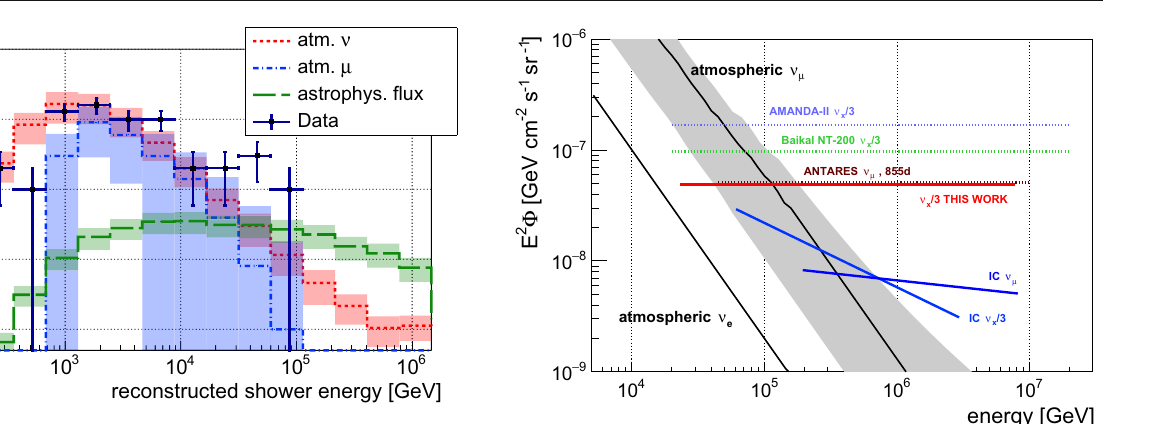
Fig. 5 The 90% C.L. upper limit on the diffuse all-flavour astrophys- ical neutrino flux obtained in this work ( solid red line ) in comparison to previously set upper limits ( dotted lines , AMANDA-II [59], Baikal NT-200 [60], and ANTARES ν μ [16]) and 2 different measurements of a diffuse astrophysical neutrino flux reported by IceCube ( solid blue lines , IC ν x / 3 [5], and IC ν μ [6]) median angular resolution of 6 ◦ for shower energies